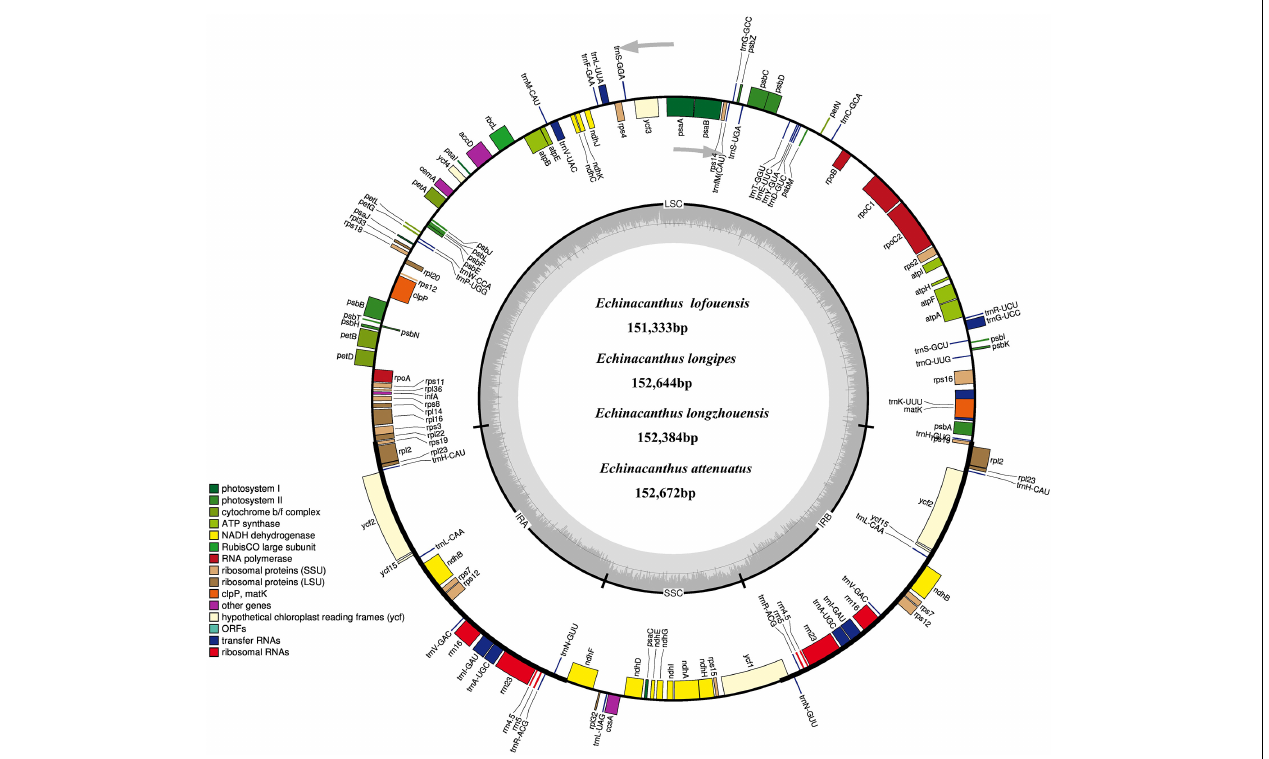
FIGURE 1 | The chloroplast genome map of four Echinacanthus species. Genes lying outside the circle are transcribed in the counter clockwise direction, while those inside are transcribed in clockwise direction. The colored bars indicted different functional group. The darker gray area in the inner circle denoted GC content while the lighter gray corresponds to the AT content of the genome. LSC, large single copy; SSC, small single copy; IR, inverted repeat.